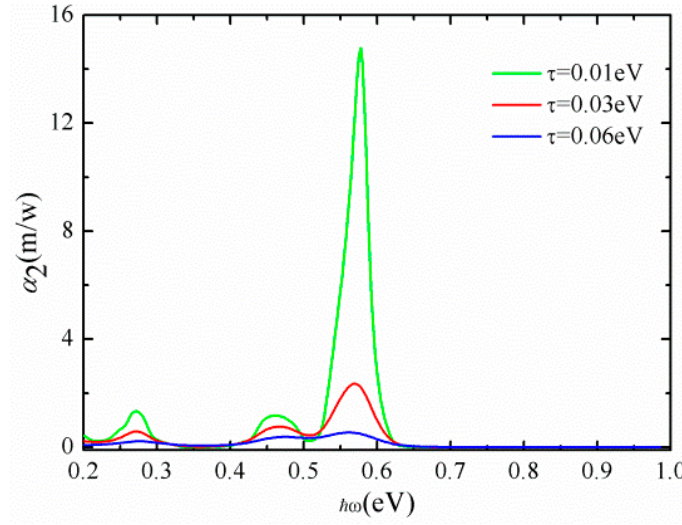
Figure 4. TPA spectra contributed from intra conduction band transitions for different electron relaxation energy in acBPNs ( N = 15).